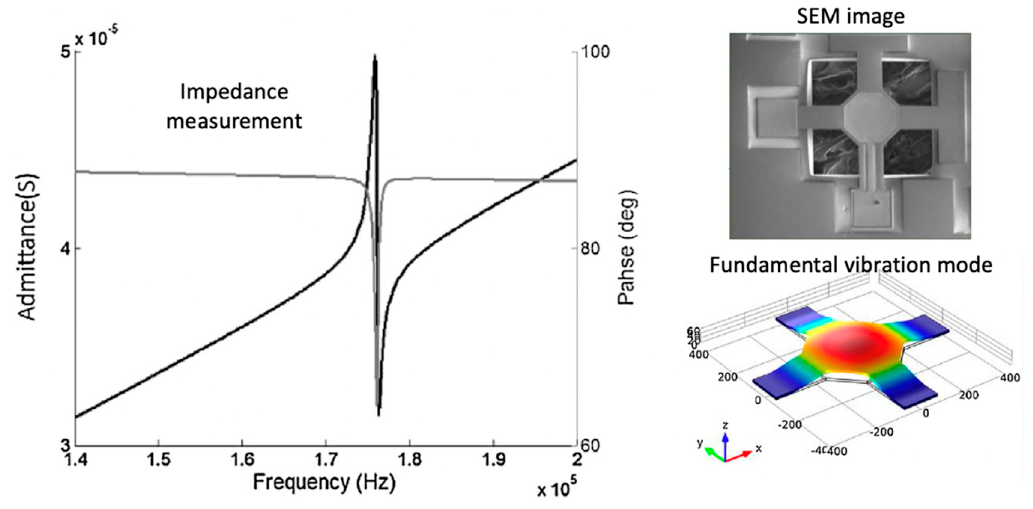
Figure 7. An example of admittance and phase plots of a MEMS AE sensor tuned near 170 kHz.